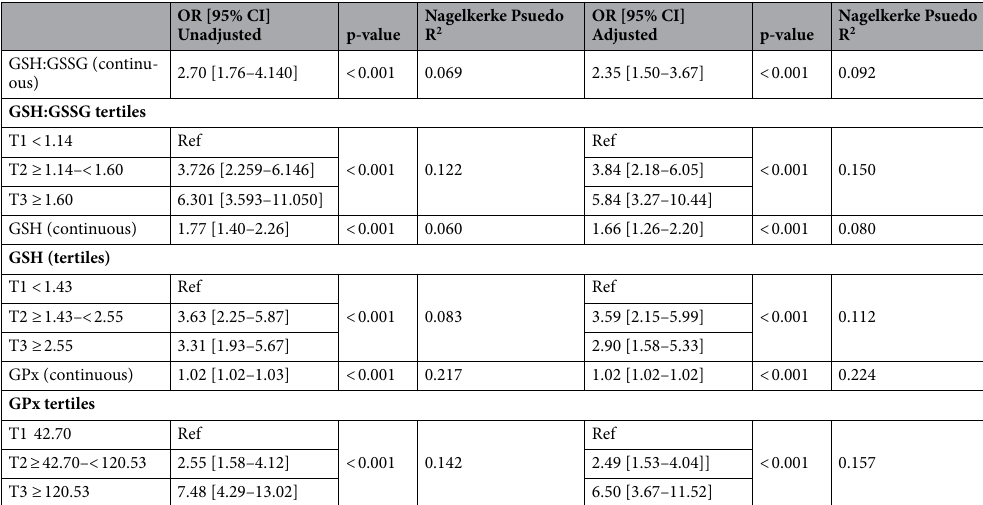
Table 7. Association between obesity and redox status. Weight status was used as a binary variable (normal- weight vs. overweight + obese). The normal-weight group was used as reference in logistic regression. The adjusted model is adjusted for age, sex, and anemia status categories. GPx glutathione peroxidase, Hb hemoglobin, OR odds ratio, CI confidence interval, GSH reduced glutathione, SD standard deviation, GSSG glutathione disulfide, BMI body mass index, WC waist circumference, Ht